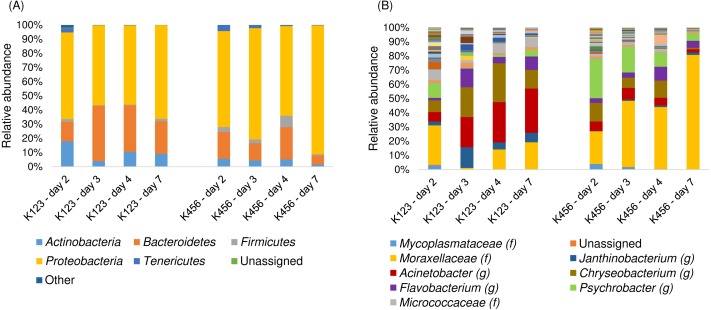
Composition of the bacterial community in samples from the storage ice.Composition of the bacterial community at (A) phylum and (B) genus level. The four bars on the left of both figures are the pooled samples from storage boxes 1–3 and the bars on the right represent the pooled samples from storage boxes 4–6. (A) The dominating phyla are illustrated in separate legends while those of very low abundance are combined in “Other” (B) The most abundant families (f) or genera (g) are illustrated in the legends.